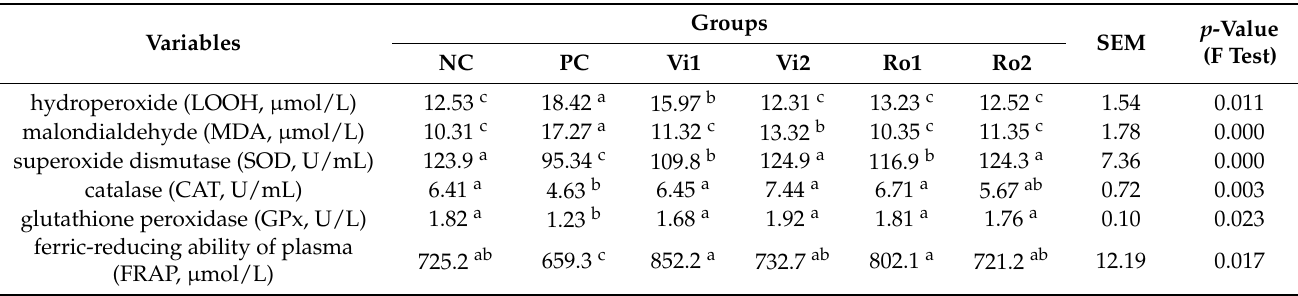
Serum oxidation indicators affected by dietary vinegar and rocket salad of stressed broiler chickens ( n =